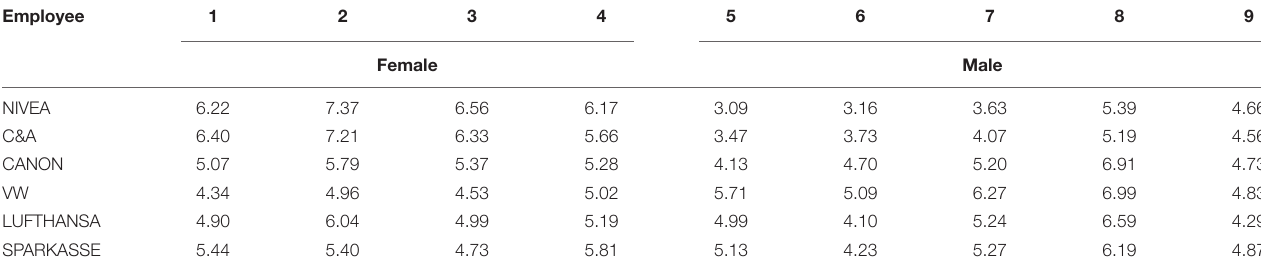
TABLE 2 | Average ratings for the visual brand fit of nine employees (highest rating = 9).